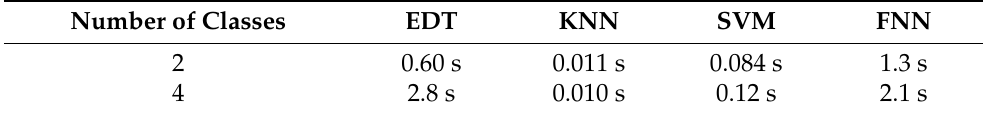
Table 2. Training time of the machine